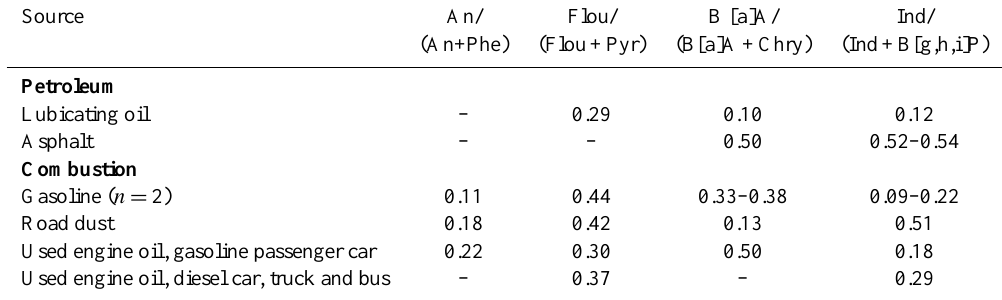
Table 2. Characteristic values of selected diagnostic ratios for petroleum and single-source combustion (Modified from Yunker et al., 2002).